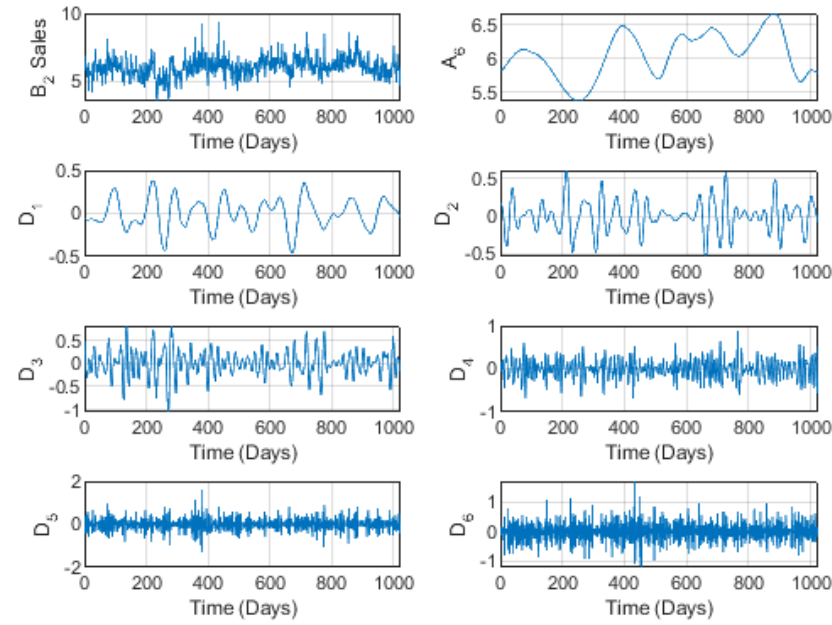
Figure 4. The wavelet decomposition of the Almarai brand B 2 sales at level